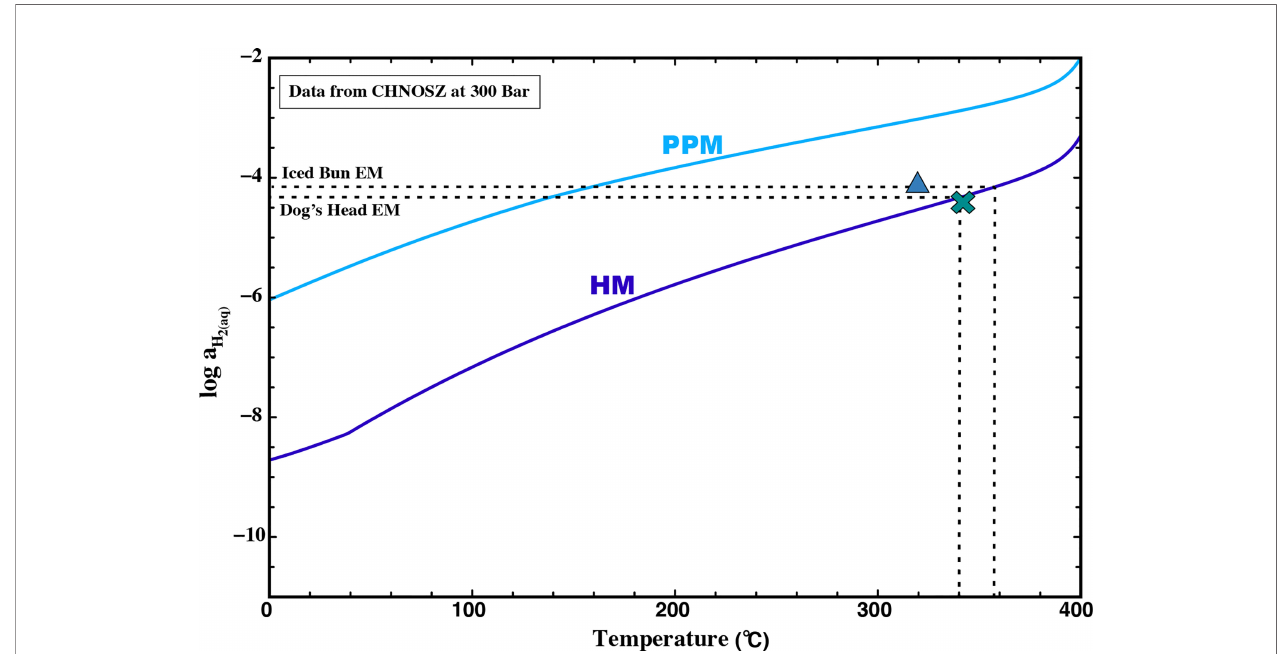
FIGURE 7 | Activity diagram showing aqueous H 2 abundances in equilibrium with pyrite-pyrrhotite-magnetite (PPM, blue line) and heamatite-magnetite (HM, purple line) at 300 bar and corresponding temperatures. The lines were drawn using thermodynamic data from CHNOSZ and references therein (Dick, 2019). Endmember H 2 concentrations and T max for E2 is shown as Dog ’ s Head (cross) and Iced Bun (triangle). The dashed line indicates endmember H 2 extrapolated to its associated temperature as a function of the HM